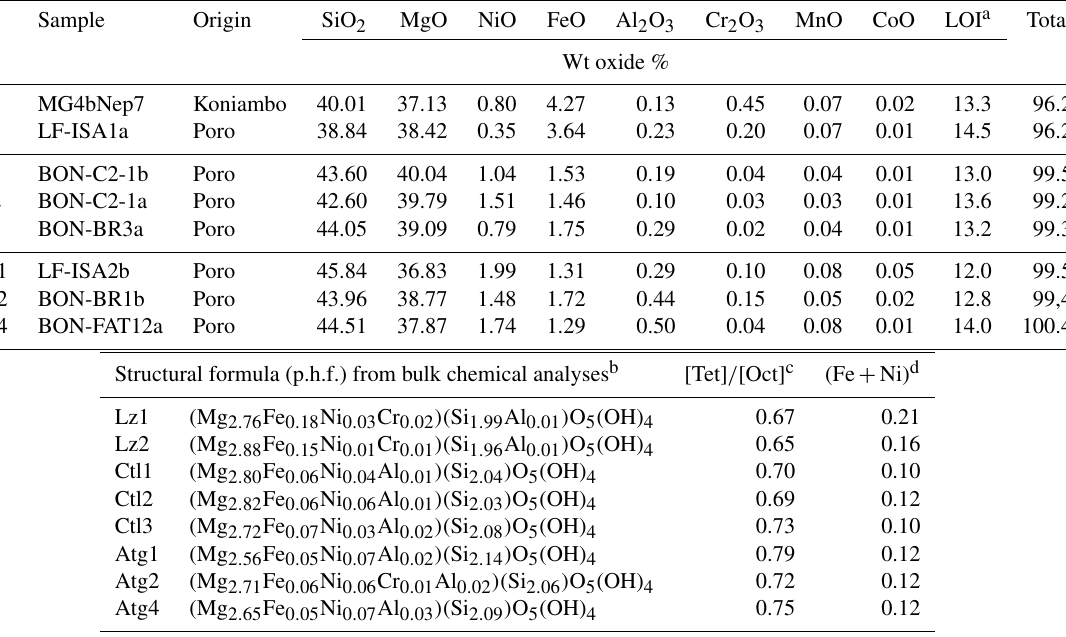
Table 1. Bulk chemical composition (weight, wt, oxide %) of the eight serpentine samples selected for this study (lizardite: Lz1, Lz2; chrysotile: Ctl1, Ctl2, Ctl3; antigorite: Atg1, Atg2, Atg4). In the table, p.h.f. signifies per half formula.